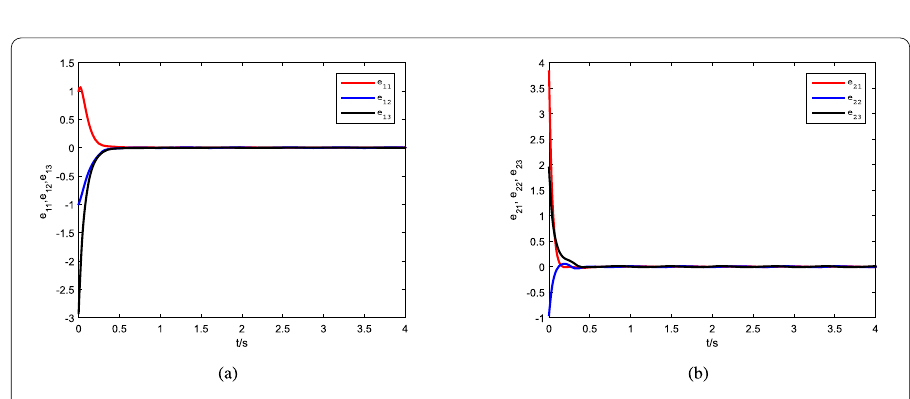
Figure 7 The error dynamics of synchronization among 3-coupled fractional-order chaotic systems